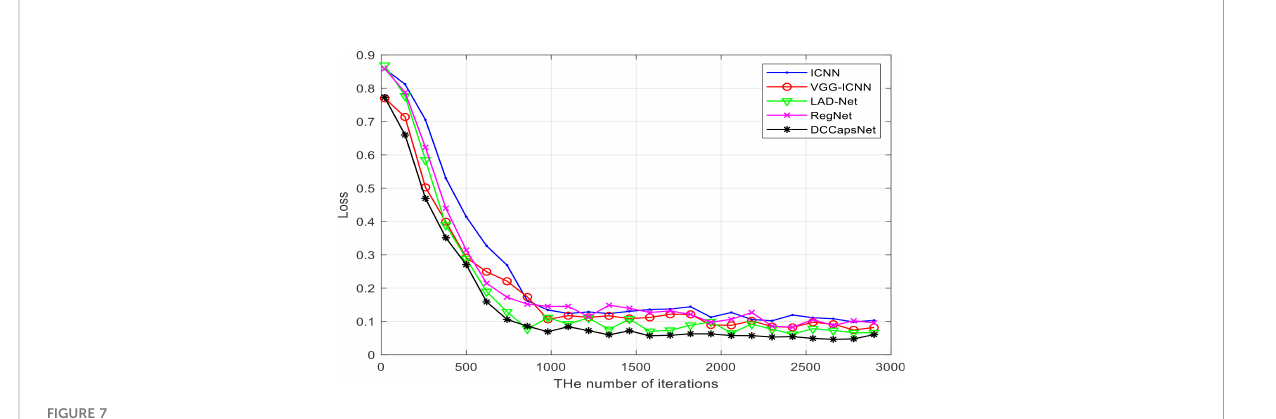
FIGURE 7 Losses of fi ve networks versus training iterations.